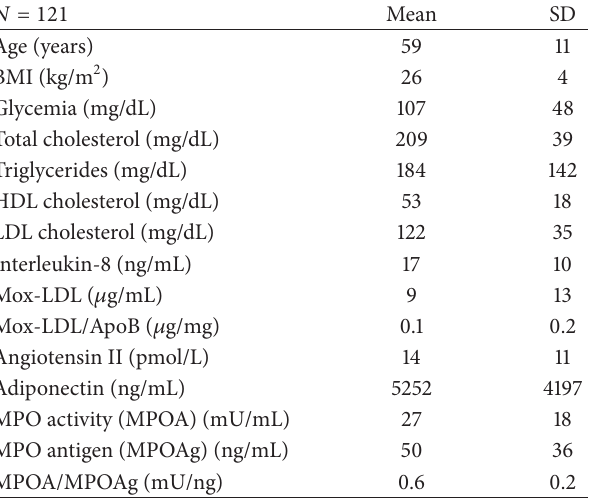
Table 1: Patient parameters.